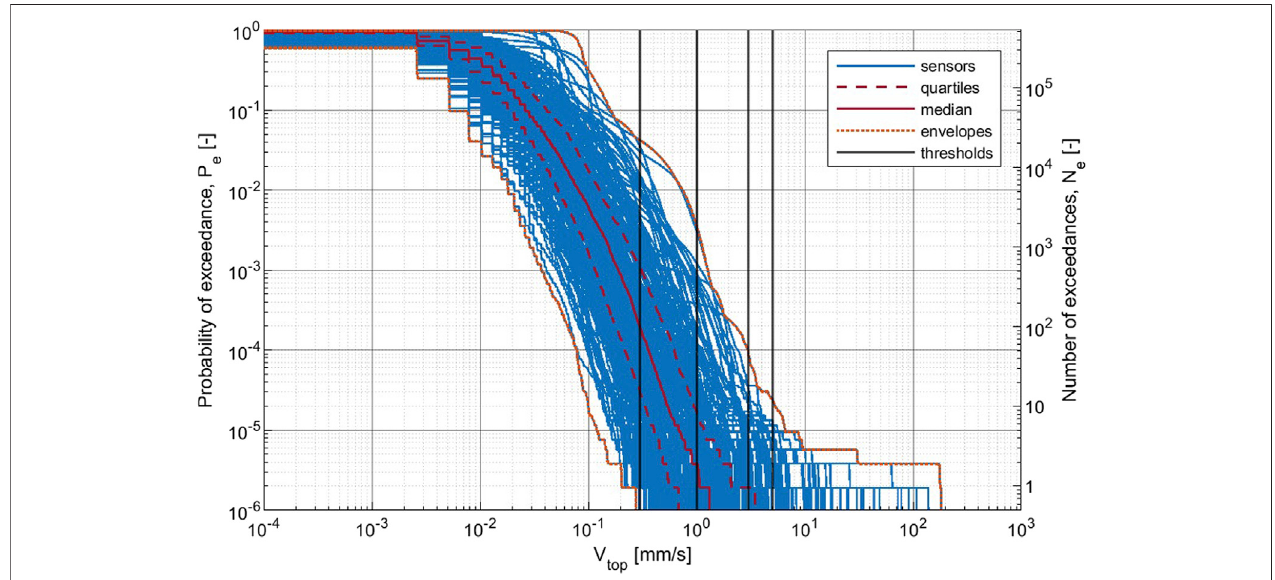
FIGURE 4 | Complementary cumulative distribution functions of the 254 one-year heartbeat datasets (blue). The graph shows the quartiles and envelopes (red) of the CCDF ’ s and indicates the velocity thresholds (black).